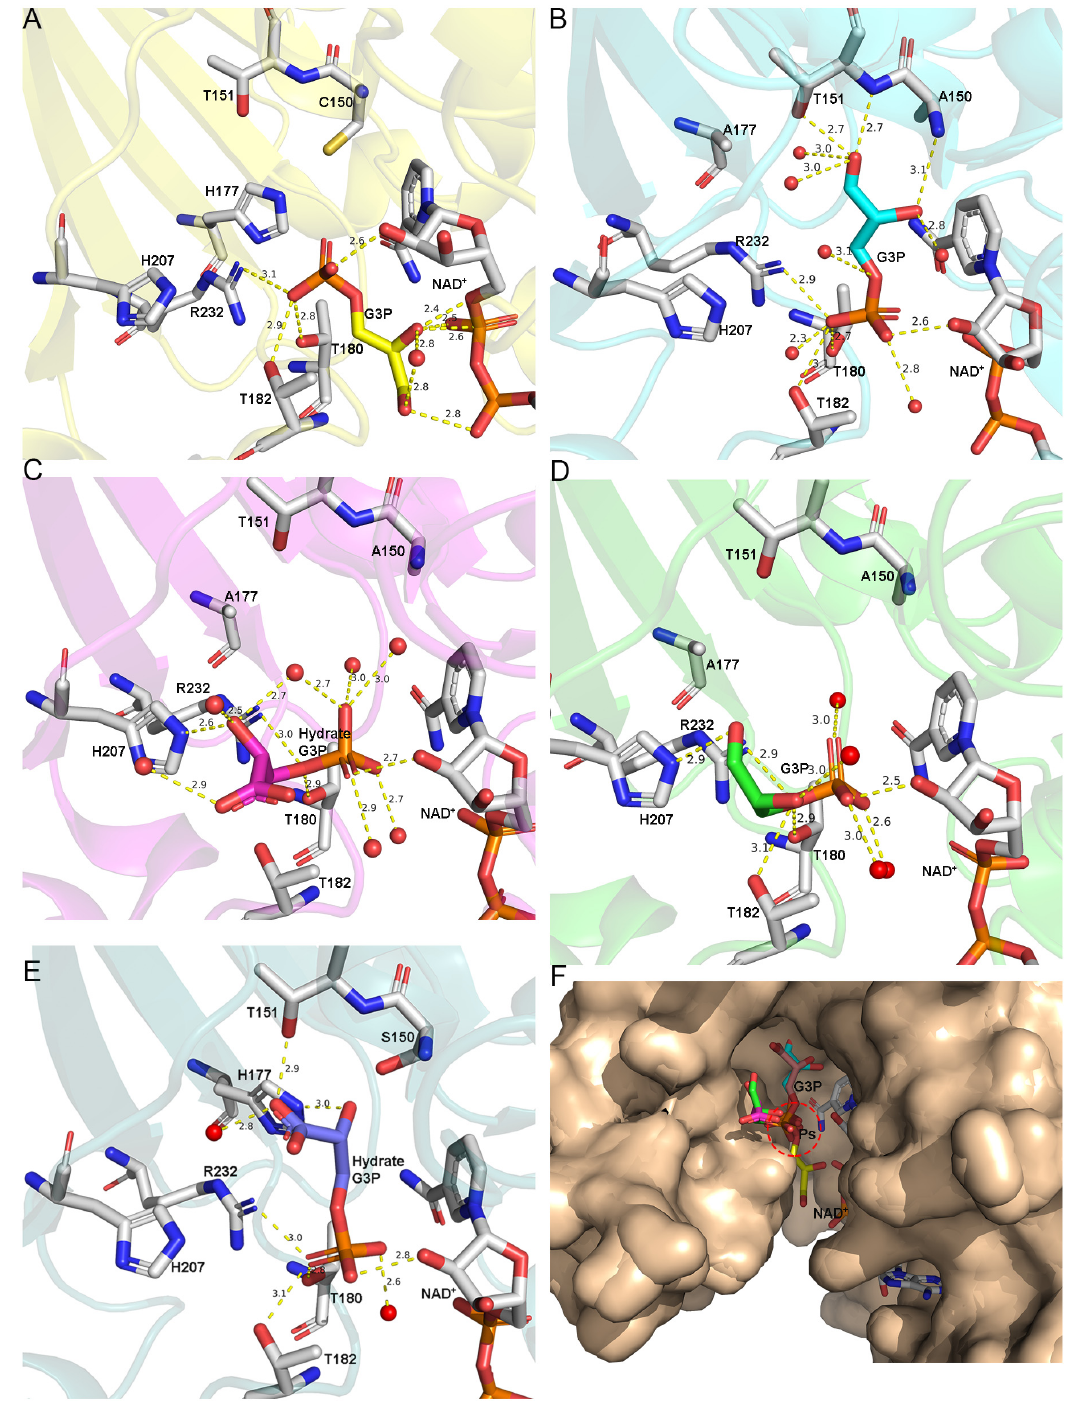
Figure 3. Different binding forms of G3P in Ec GAPDH1. The amino acids and water molecules that interact with G3P are shown as sticks with silver carbons and spheres with a red color. Cartoon representation of subunits where hydrogen bonds are depicted by yellow dotted lines. The carbon of G3P is the same as that of the Ec GAPDH1 subunit. ( A ) The O subunit of WT.NAD.G3P (7C5P) is shown in yellow. ( B – D ) The Q, O, and P subunits of C150A+H177A.NAD.G3P (7C5M), respectively. ( E ) G3P binding in C150S.NAD.G3P (chain Q, PDB 7C5K, tv-blue). G3P in the Q subunit of C150S.NAD.G3P and the O subunit of C150A+H177A.NAD.G3P are in the hydrate form. G3P in the other subunits is in the aldehyde form. ( F ) Superimposition of the O subunit of WT.NAD.G3P (7C5P); the Q, O, and P subunits of C150A+H177A.NAD.G3P (7C5M); and the Q subunit of C150S.NAD.G3P with the P subunit of Tm GAPDH (3K73). The subunit is depicted in a wheat-like color, whereas G3P is depicted using